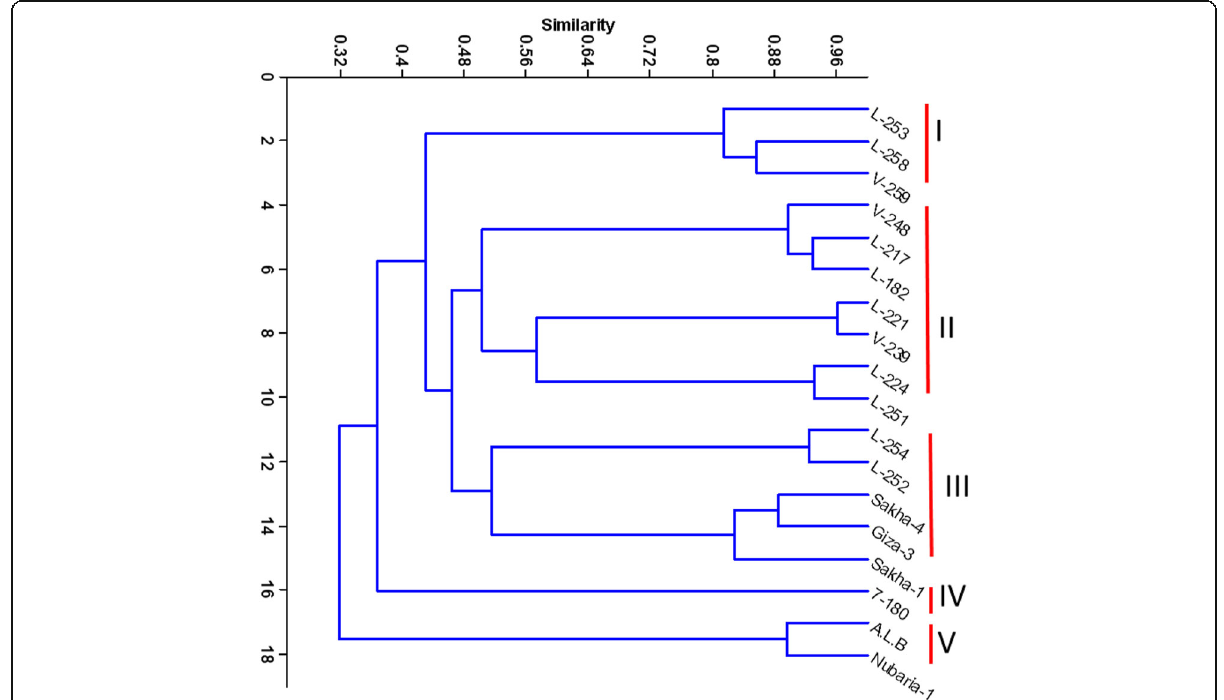
Fig. 1 Unweighted pair group method with arithmetic average (UPGMA) cluster for the 18 faba bean genotypes based on their allelic SRAP marker